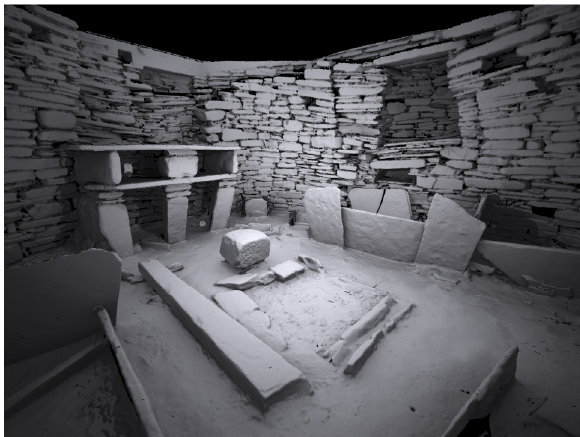
Figure 9. Cross-section through point cloud of Maeshowe Figure 7. Meshed point cloud data showing interior of House 7 chambered tomb, coloured by intensity values © CDDV 2010. at Skara Brae. The mesh was created with an interpolation step of 8mm and contains 6 million polygons. The model was rendered in 3D Studio Max using the VRAY rendering engine with a physical camera © CDDV 2011.